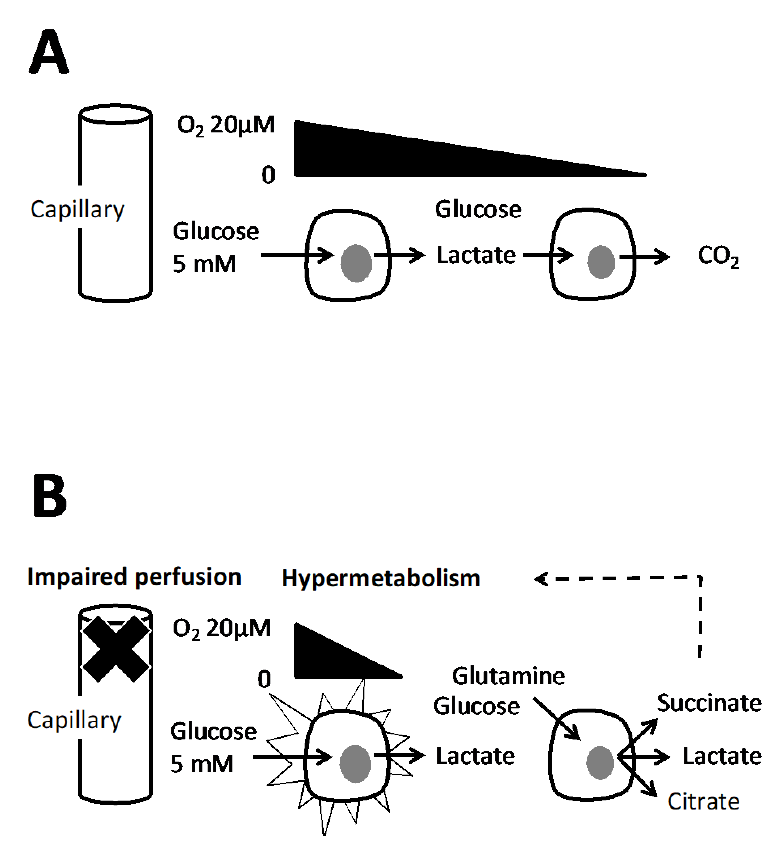
Figure 3. A capillary feeds different layers of cells schematized as two cells with a different distance to capillary. The flux of oxygen and of wastes are figured by arrows, ( A ) the oxygen supply is sufficient however Warburg effect may take place (see Section 7) but lactate is eventually oxidized in CO 2 . ( B ) Alteration of vasculature and/or hypermetabolism results in an oxygen supply that could not cover all cellular needs. Then metabolic adaptations take place in the second cell (see text) with the result of release of lactate, citrate and succinate. They trigger hypermetabolism to reimburse the oxygen debt or stimulate biosynthesis. The dotted arrow suggests that these effects could be exerted locally.